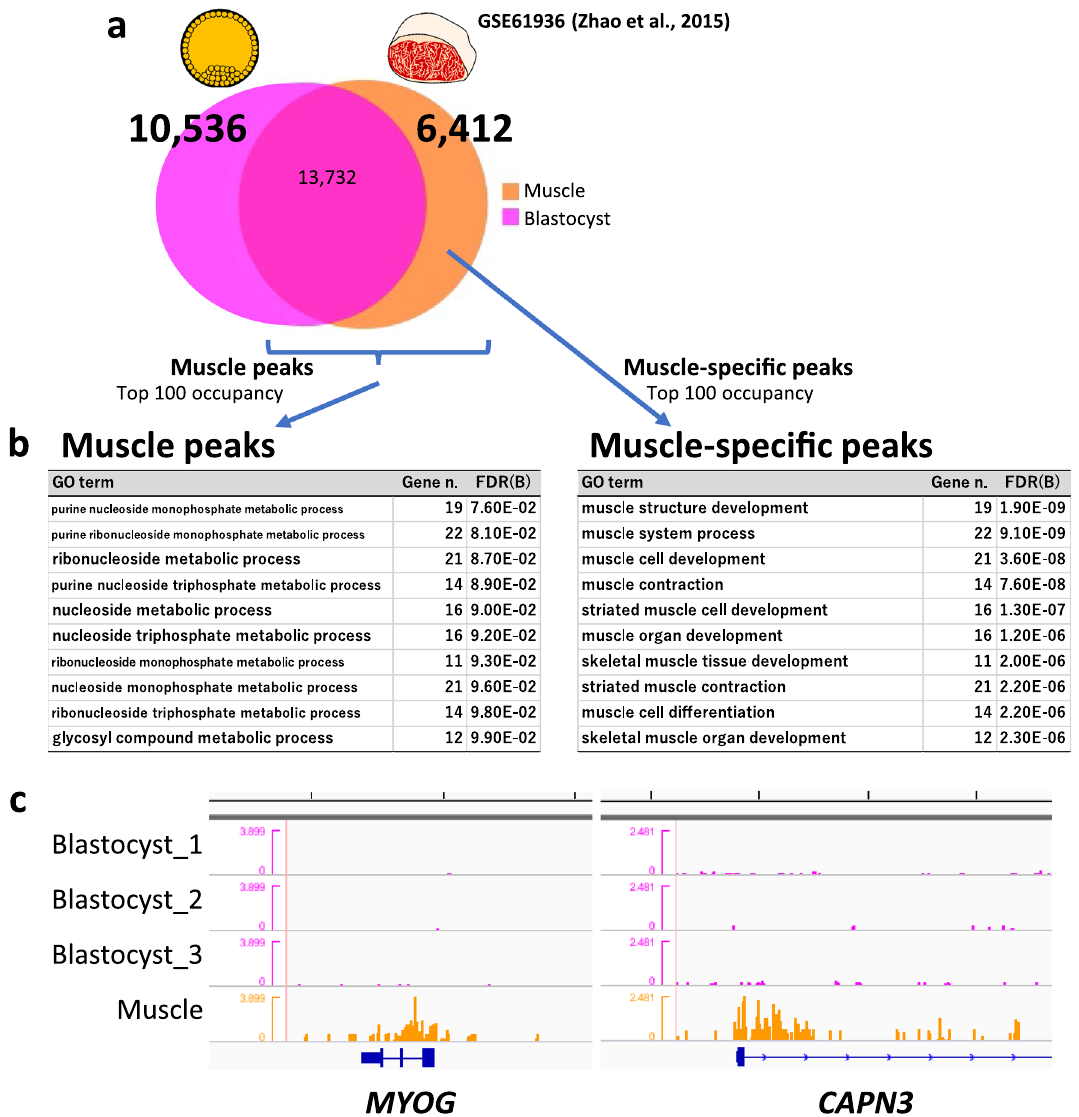
Figure 3. Characterization of blastocyst- and muscle-specific H3K4me3 modifications. ( a ) Processing of ChIP- peaks in muscle and blastocyst samples. The numbers show those of the peaks. The sum of common (intersect) and specific peak numbers is not identical to the original peak number in each sample because some peaks were separated into multiple peaks to represent intersects. ( b ) Top 10 significant GO terms for biological process enriched by the genes with the top 100 highest peak occupancy rates. Gene n. represents the numbers of related genes. FDR(B) indicates the Benjamin false discovery rate. ( c ) Examples of the H3K4me3 landscape for muscle- specific peaks ( MYOG and CAPN3 ) around their TSSs. Five-kb graduations are shown in the top imprinted genes listed in a previous bovine study 8 and two differentially methylated regions (DMRs) related to bovine fetal overgrowth (KvDMR1 of KCNQ1OT1 and IGF2R/AIRN DMR) were selected for investigation, and we found that 30 TSSs and the two DMRs had H3K4me3 peaks both in blastocysts and liver. The average profile plot of the 30 TSSs again exhibited overall similar profiles between the two different tissues (Fig. 5a). Meanwhile, we could also extract tissue-specific H3K4me3 modifications, as shown in Fig. S3. PCA of the common peaks in the two tissues extracted the inter- (PC1) and intra-tissue (PC2) differences represented by differential patterns of H3K4me3 modifications among the tissues and samples (Fig. 5b,c). The imprinted genes IGF2R (with IGF2R/ AIRN DMR) and KCNQ1OT1 (with KvDMR1), both of which are implicated in fetal overgrowth syndrome 8 , exhibited a relatively high contribution to intra-tissue differences (PC2). In addition, we further investigated the correlation between the levels of H3K4me3 around TSSs and the expression levels of these imprinted genes calculated from publicly available RNA-seq data. Despite the independent experiments, the levels of H3K4me3 in both tissues exhibited significant correlations with the gene expression levels (Fig. 6a). Furthermore, the relative difference between blastocyst and liver in terms of H3K4me3 modifications around the TSSs of the imprinted genes well reflected the relative difference in gene expression levels between the two tissues (Fig. 6b).